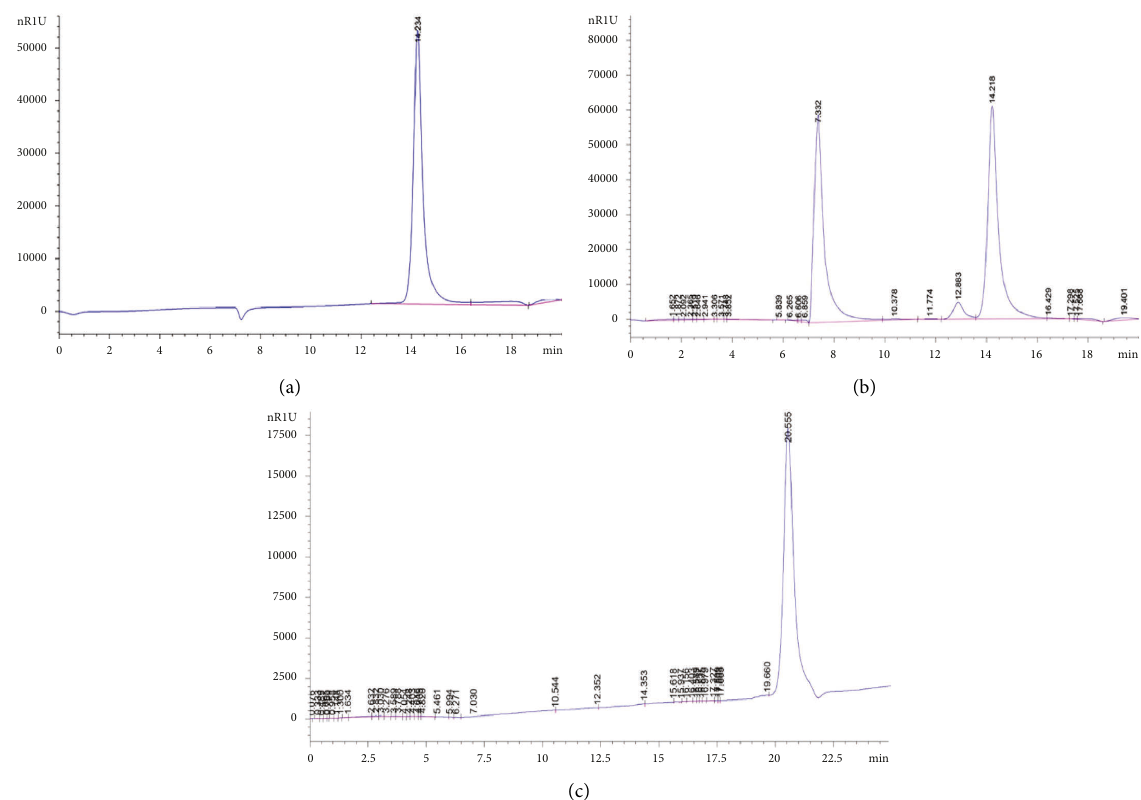
Figure 2: HPLC analysis of (a) glycerol (commercial), (b) glycerol residue, and (c)